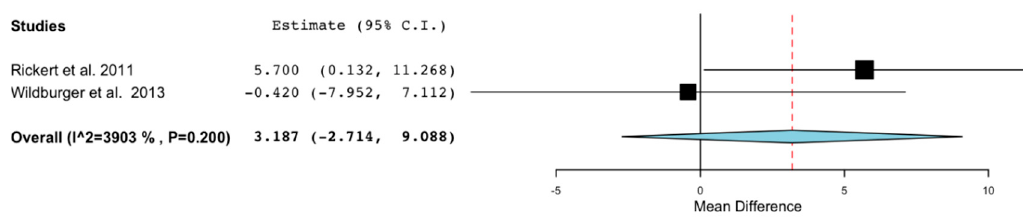
Figure 3. Forest plot of new bone formation between control vs. grafts with application of stem cells in maxillary sinus regenerations.